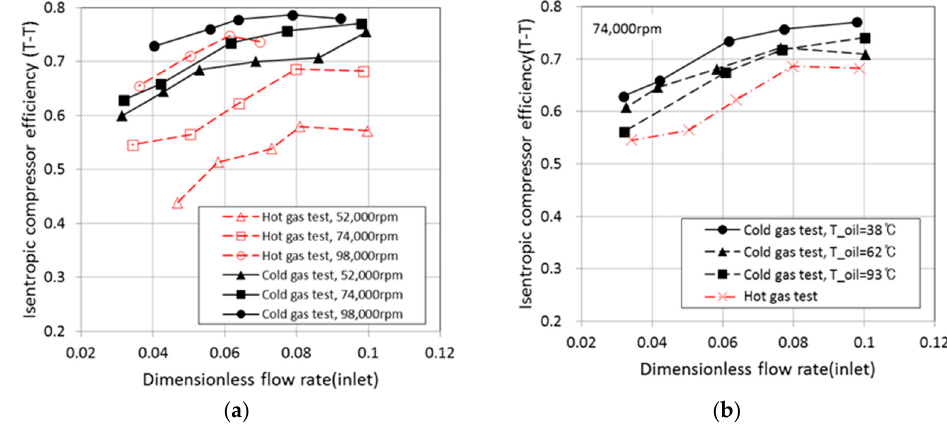
Figure 3. Isentropic compressor efficiency in a cold gas test and hot gas test. ( a ) Comparisons of cold gas test results and hot gas test results; ( b ) comparisons of oil inlet temperature variation cold gas test results.